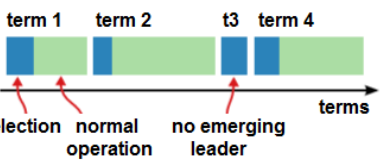
Figure 2. In the Raft algorithm, time is divided into terms, and each term starts with an election [24].